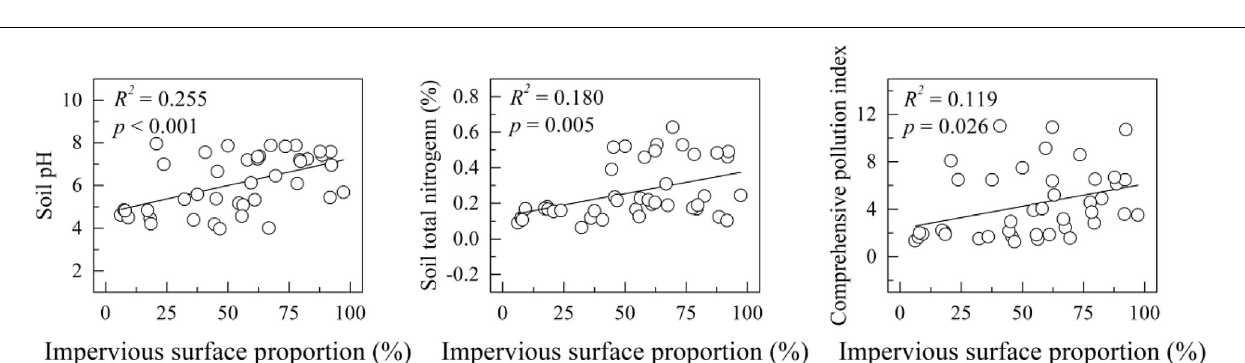
FIGURE 2 | Variations of soil mesofauna abundance and diversity with soil property. The cross-shape points are data points excluded in the linear regression. R 2 and p were the fitness and significance of the linear regression models.